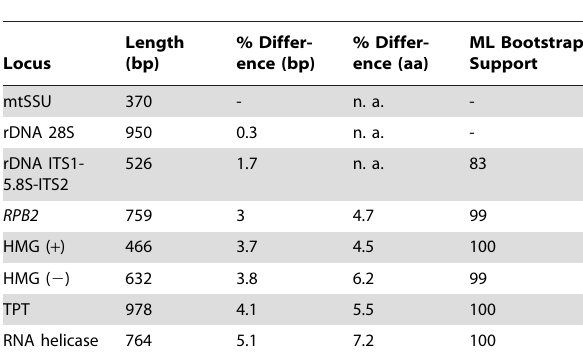
Table 3. Comparison of the phylogenetic signal obtained from different genes using different methods for delimitation of the two cryptic species, Rhizopus oryzae s. s . and Rhizopus delemar ; percent difference is depicted for both DNA (bp) and amino acids